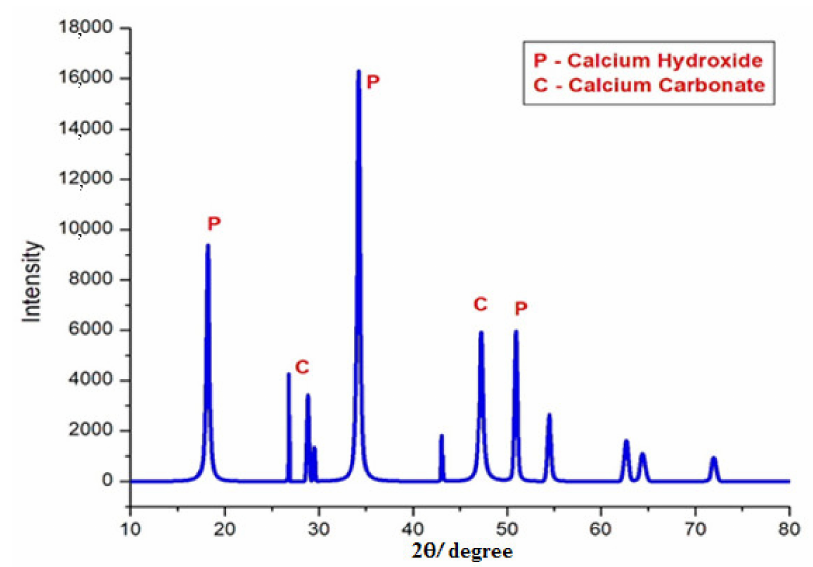
Figure 1. XRD pattern of hydraulic